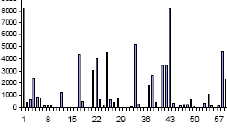
Fig. 2 Sports frame and its 64 bin